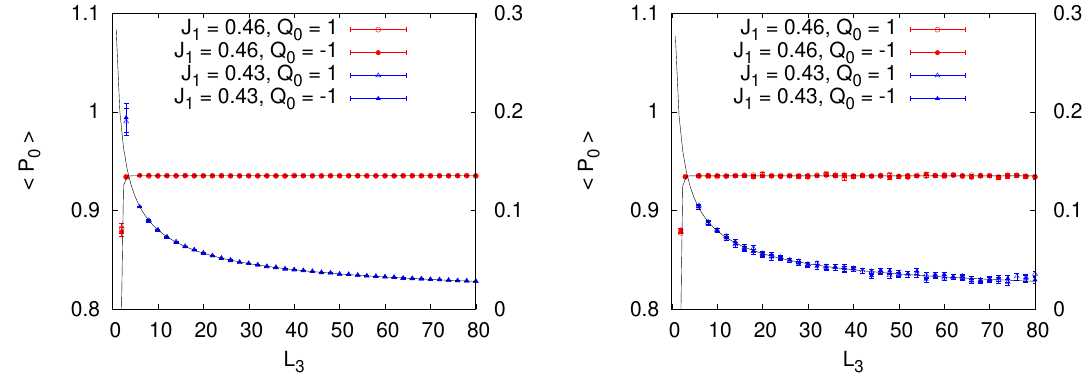
Figure 4 . Demonstration of the dependence of the h P 0 i line on the transverse direction T for small J 2 = 0 . 10 and different J 1 = 0 . 43 and J 1 = 0 . 46 for both topological charges. Demonstration of the dependence of the h P line on the transverse direction L for large J = 1 . 10 and different 0 i 3 2 J 1 = 0 . 43 and J 1 = 0 . 46 for both topological charges. The left axis shows the values of the data which has a constant nature, whereas the data sets falling towards zero have their values shown on the right